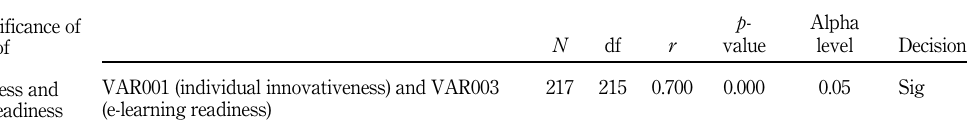
Table 2. Sociodemographic data of respondents ( N 5 217)